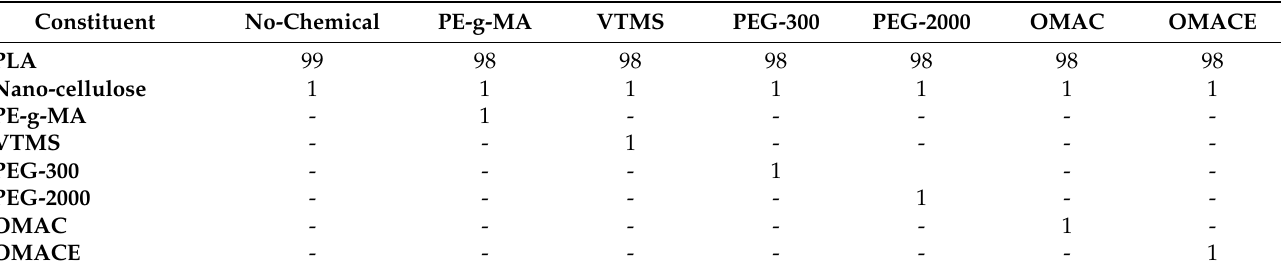
Table 3. The composition of NC/PLA composites, in ( w / w )%.